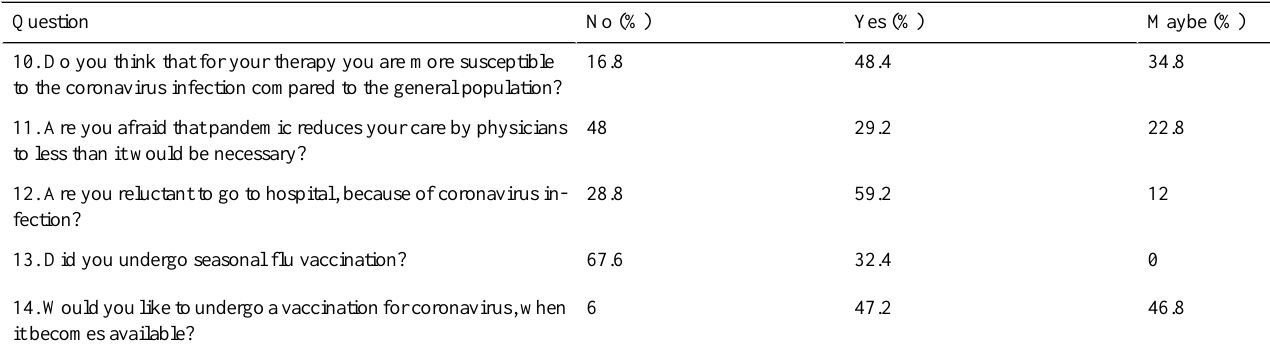
Maybe (%)Yes (%)No (%)Question